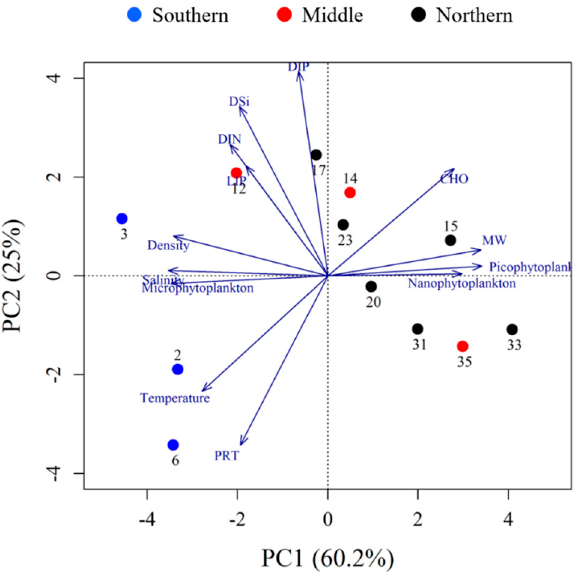
Figure 5. The principal component analysis performed from sampling stations. The environmental variables taken into consideration are temperature, salinity, density, nutrients (DIP; dissolved inorganic phosphate, DSi; dissolved inorganic silicate, DIN; dissolved inorganic nitrogen, nitrite + nitrate + ammonium), MW (meltwater, %), relative contribution of phytoplankton size classes (microphytoplankton, picophytoplankton, and nanophytoplankton), and relative contribution of biochemical pools (carbohydrates, CHO; proteins, PRT; lipids, LIP). Rotated eigenvectors for each parameter are indicated by arrows. Table 2. A summary of eigenvectors of each environmental variable, eigenvalues, percentage (%) of variance explained by the first two axes resulted from the PCA. DIP; dissolved inorganic phosphate, DSi; dissolved inorganic silicate, DIN; dissolved inorganic nitrogen (nitrogen, nitrite + nitrate + ammonium).